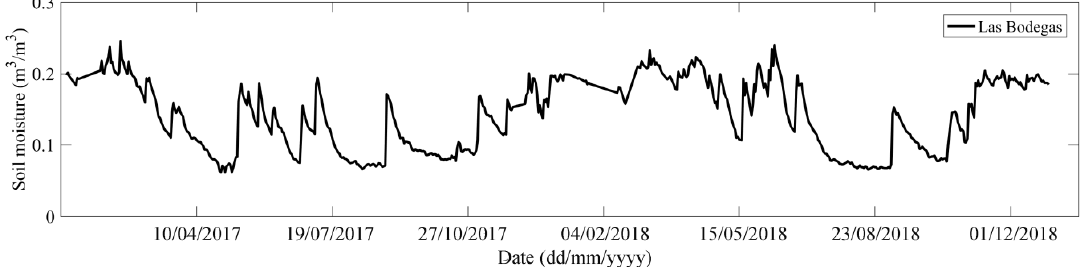
Figure 2. Time series of in-situ soil moisture in the station Las Bodegas.